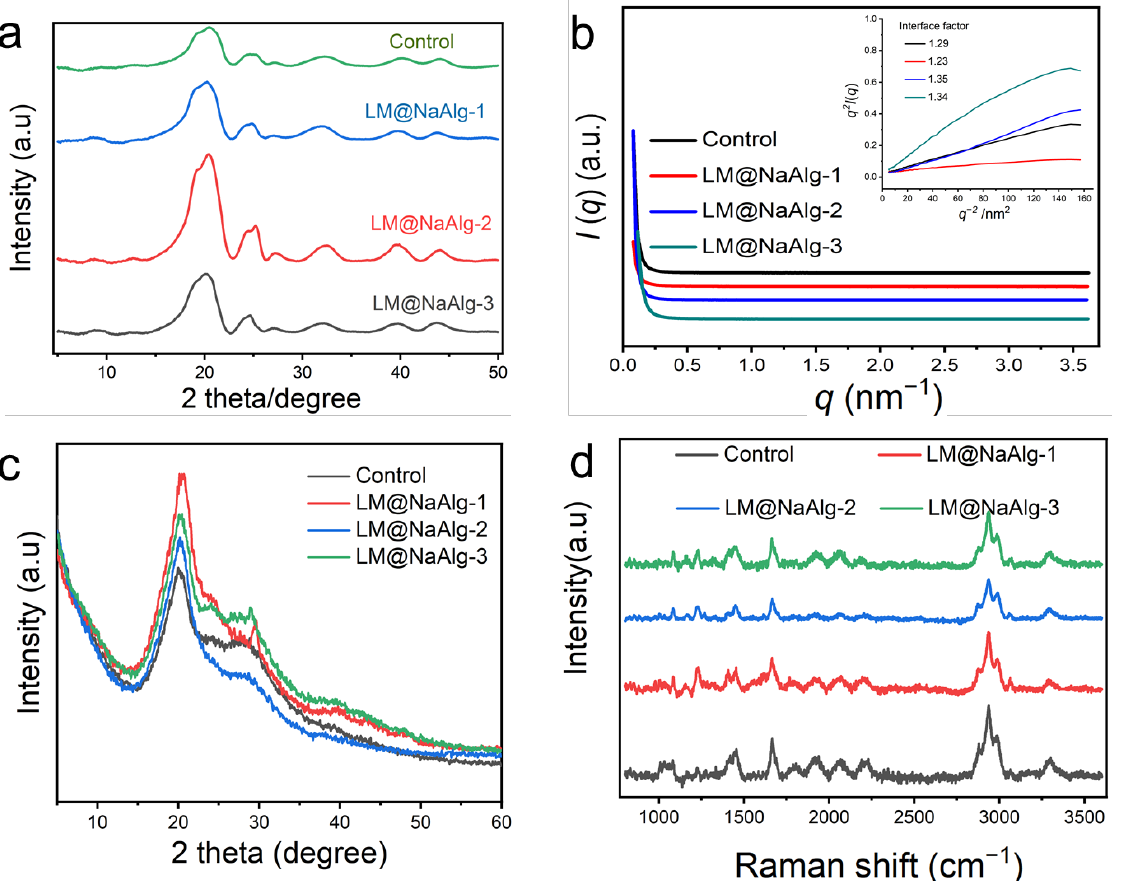
Figure 6. Crystalline structure characterization of silk fibers. ( a ) 1D WAXD of LM@NaAlg modified silk. ( b ) SR-SAXS patterns of degummed silks. The inset in panel b is the q2I(q)–q-2 curve based on the modified Porod formula. I(q) is the scattering intensity and q is the scattering vector. The interface factor is listed in panel (b). ( c ) XRD patterns of the silk fibers. Silk fibers are modified with different concentrations of LM@NaAlg nanodroplets and Control. ( d ) Raman spectra of the LM@NaAlg nanoparticles with different melting temperatures in the silk fibers of the silkworms fed with the diets that contained different concentrations of LM@NaAlg. The position of the characteristic peak was not significantly different between the groups.